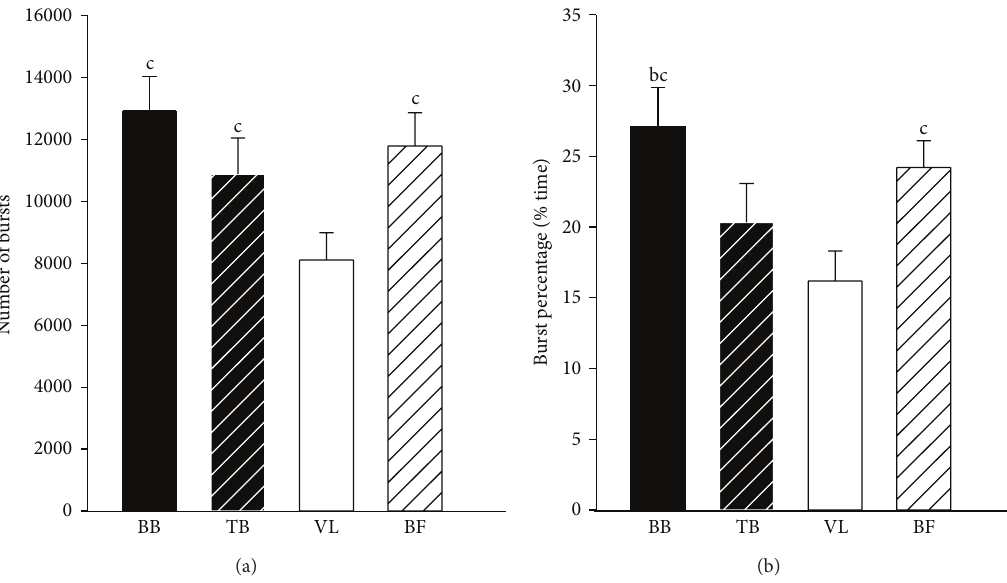
Figure 2: Muscle effect on number of bursts and burst percentage for old adults. (a) Number of bursts; (b) burst percentage. BB: biceps brachii; TB: triceps brachii; VL: vastus lateralis; BF: biceps femoris; %: percentage. a Significantly different from TB; b significantly different from VL.